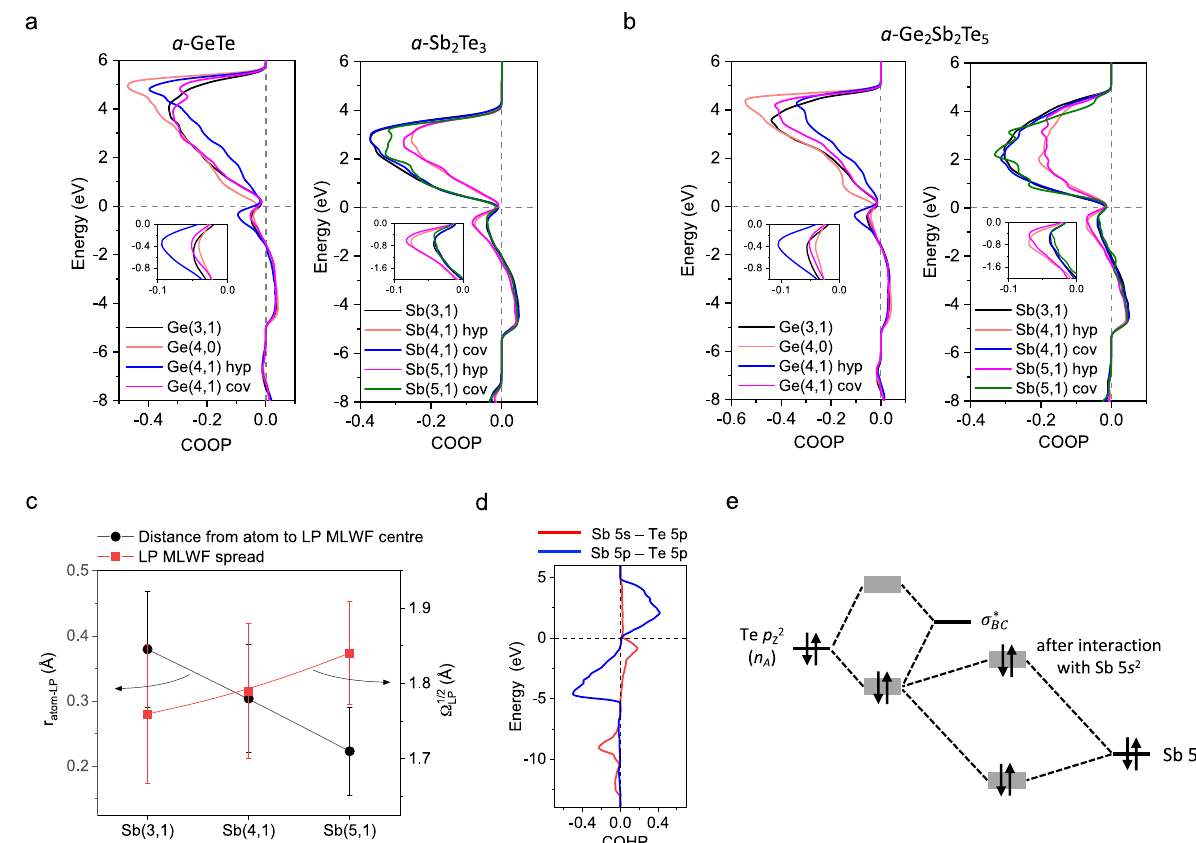
Fig. 5 Revised hyperbonding model involving cation s 2 LPs. Crystal-orbital overlap populations (COOPs) for the chemical bonds of structural units in: a binary a -GeTe and a -Sb 2 Te 3 ; and b ternary a -GST. The Fermi level is indicated by the horizontal dashed line. The magni fi ed COOP data near the Fermi level are shown in the inset. The abbreviations ‘ hyp ’ and ‘ cov ’ denote hyperbonds and covalent bonds, respectively, for each type of structural unit. A clear distinction between the hyperbonds and covalent bonds is made from their COOP pro fi les. c Distance distributions for a central atom (Sb) and MLWF LP centres for different units in a -GST. The spreads of MLWF LP ( Ω 1 = 2 LP ) values are also shown. d Crystal-orbital Hamilton populations (COHPs) for the hyperbonds of Sb(4,1) units in a -GST. Orbital-resolved COHP s for Sb 5 s – Te 5 p ( s - p ) and for Sb 5 p – Te 5 p ( p - p ) are depicted. Note the antibonding character (positive COHP value s ) for Sb 5 s – Te 5 p states at the top of the valence band. e A schematic interaction-energy diagram for an LP ( n A ) stabilisation (hyperbonding) interaction with a nearby antibonding orbital ( σ (cid:1) BC ) and with an Sb 5 s 2 (LP)